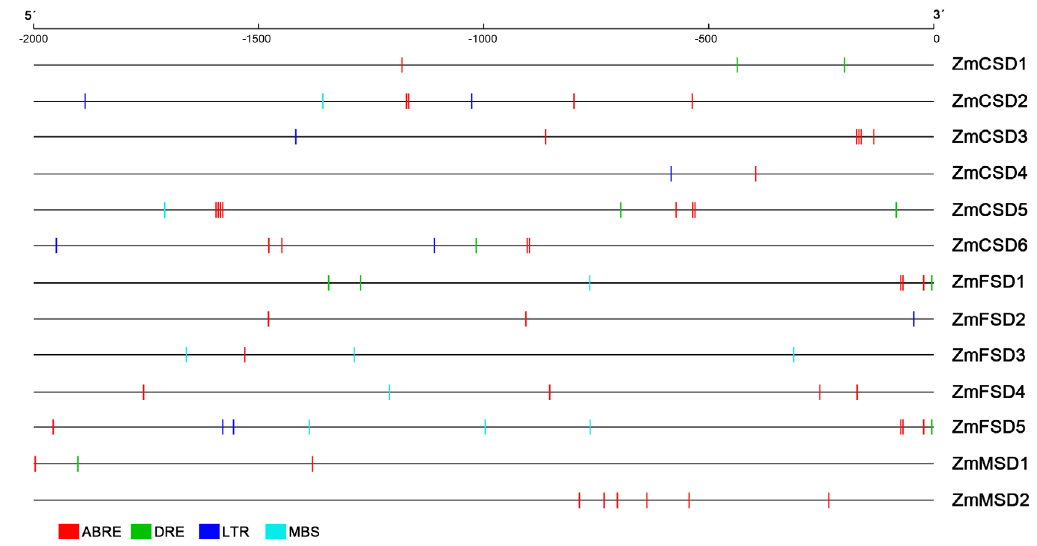
Figure 5 ‒ Cis -elements in the promoter regions of the ZmSOD genes. Four types of putative stress-responsive cis -elements, including ABRE, DRE, LTR and MBS, were shown with different